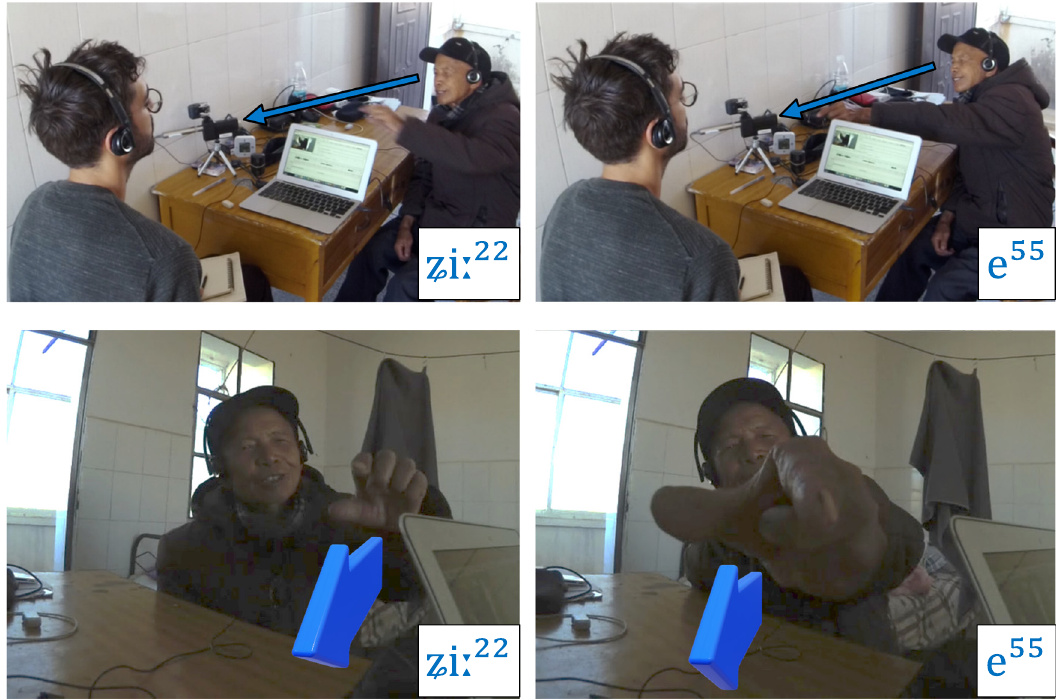
Figure 6: BLW uses speaker deictic to refer to camera lens as his hand approaches it. Figures on top row and bottom row correspond to the exact same frame captured by a lateral and a frontal camera, respectively.